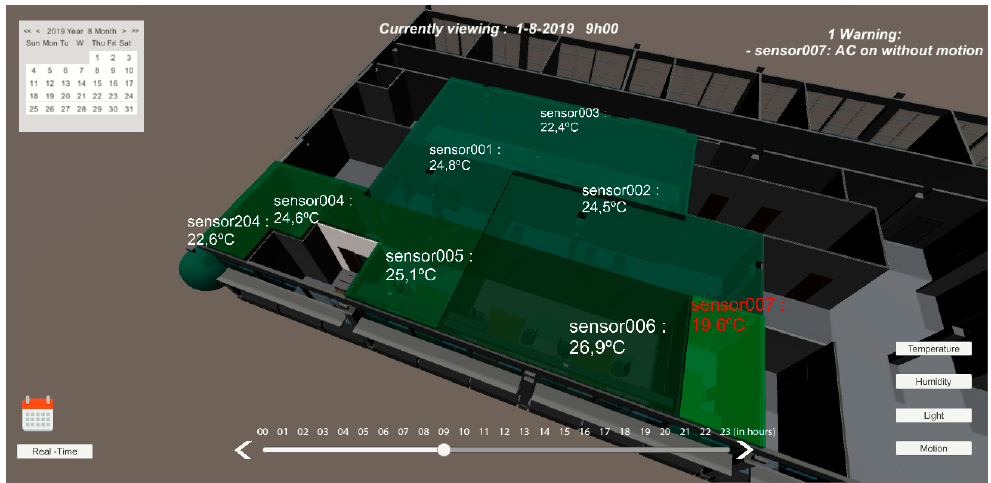
Figure 14. User interface with temperature mode selected for 01-08-2019 at 09:00 h.